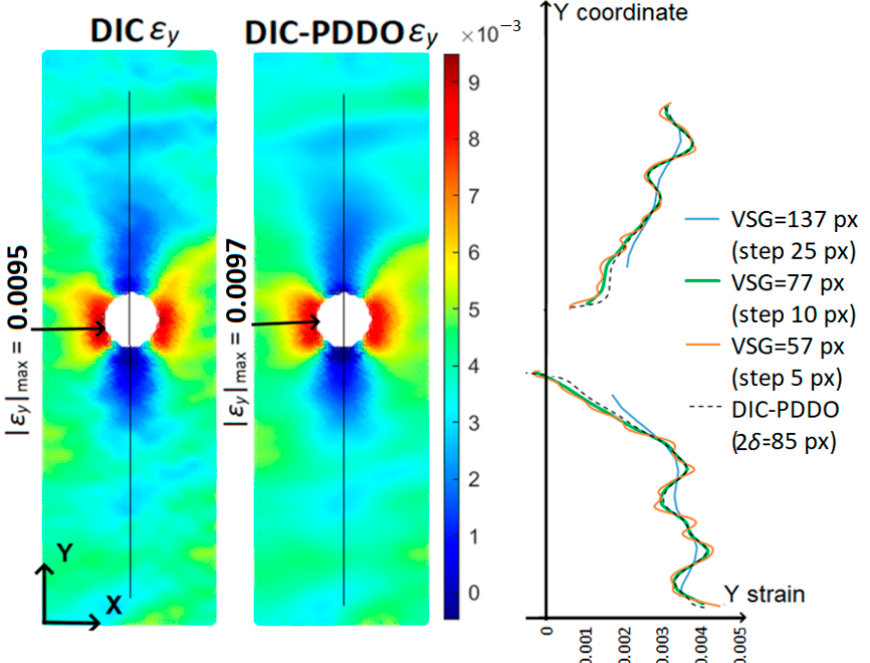
Figure 13. The problem of plate with hole analyzed in [12–14] (also see Figure 1) extended by the DIC-PDDO strain solution.